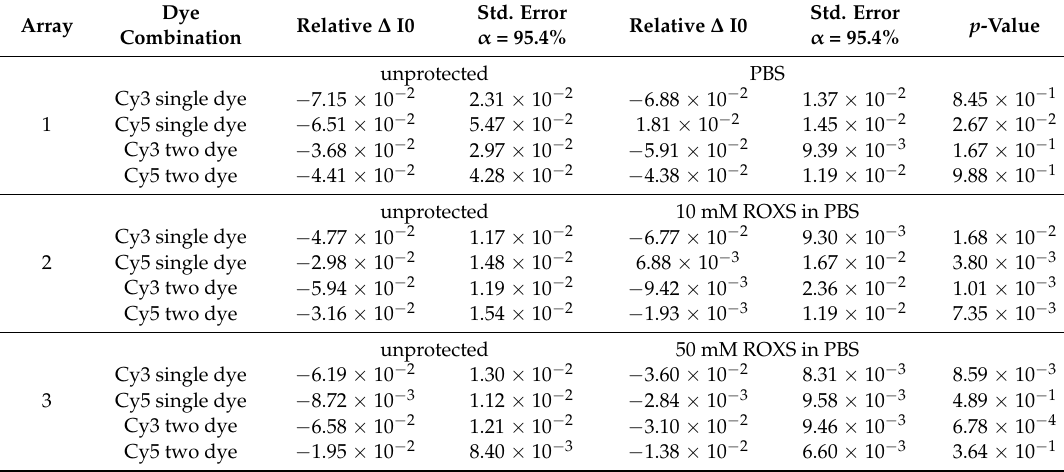
Table 2. Results and statistical metadata regarding the mean spot intensity percent change after 10 scans (relative ∆ I0) of the 24 gene